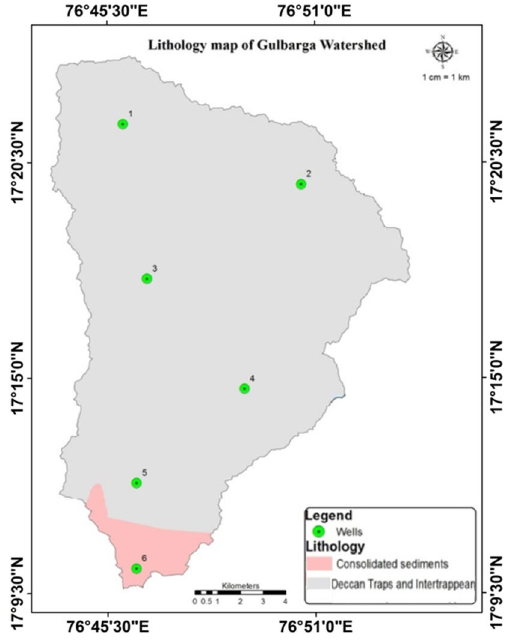
Fig. 2 Lithology map of Gulbarga